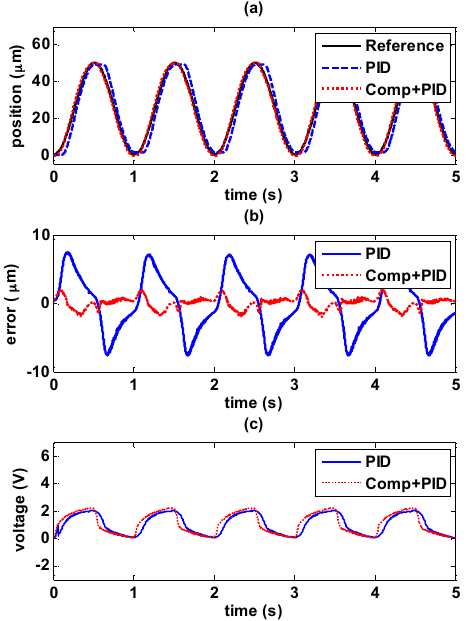
Sinusoidal wave with the amplitude of 50 μ m and higher frequency at 1 Hz is tested and shown in Figures 19 and 20. in Figures 19 and 20.